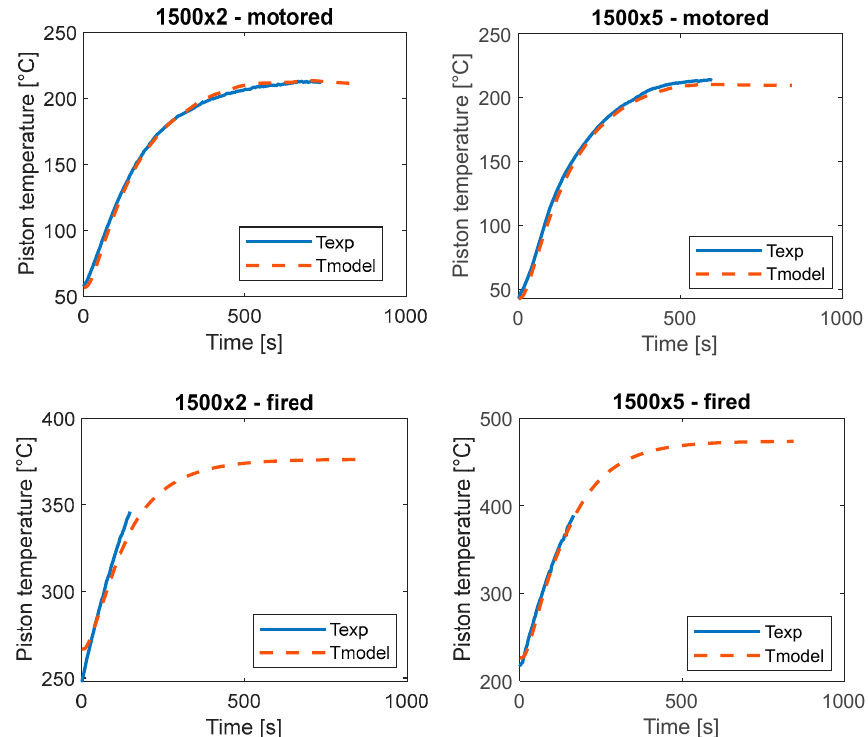
Figure 9. Comparison of the modeled and experimental measurements of the transient of temperature in motored ( top ) and fired ( bottom ) conditions of the piston, for the engine running at 1500 rpm [17] Reprinted with permission from Ref. [17] Copyright 2019 SAE International.